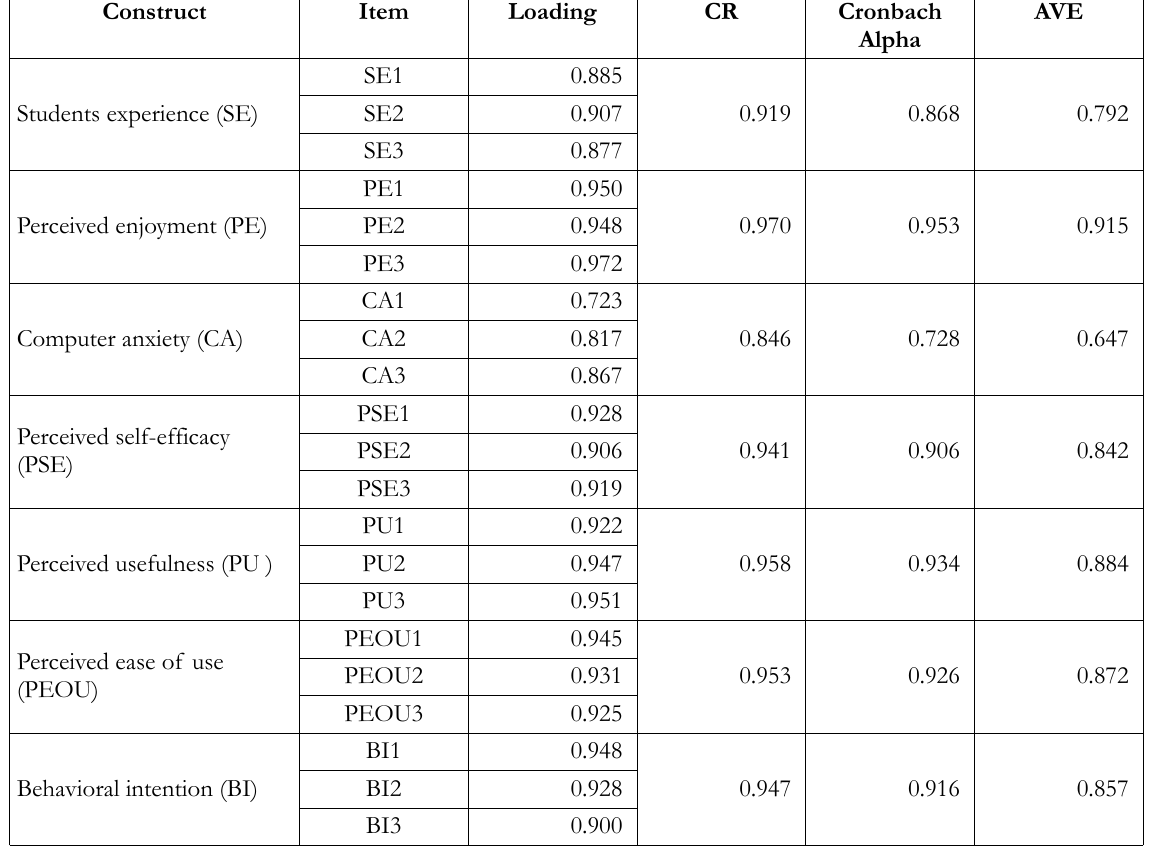
Table 2. Results of Measurement (Outer) Model